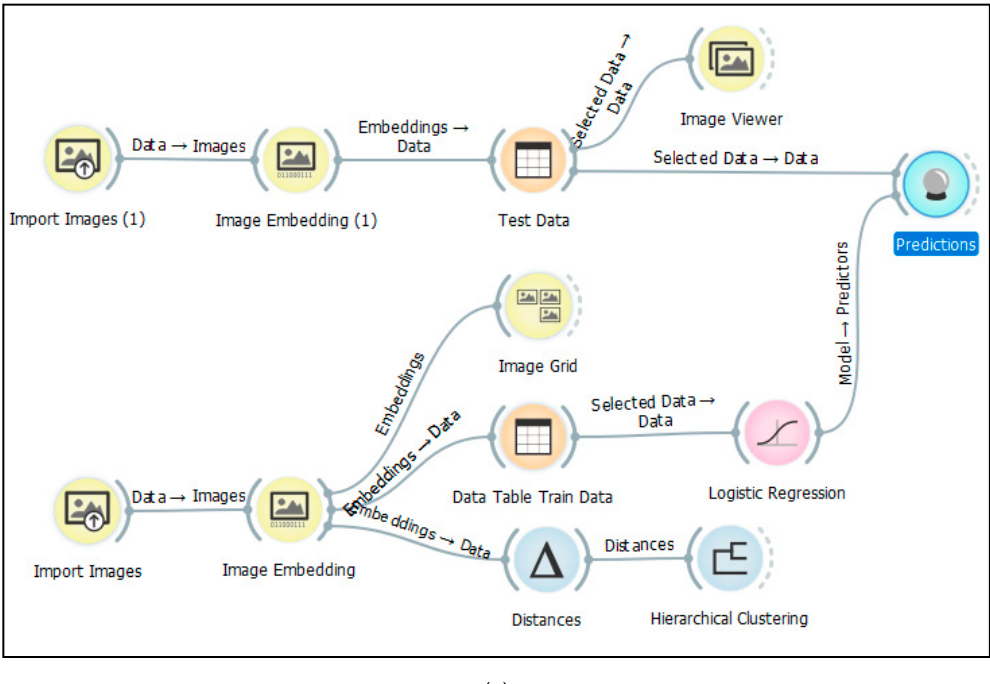
Figure 6. Image grid in Orange with the thumbnail of the tested map, with four evident clusters arranged according to base maps, historical, aerial, and black and white (author’s work).